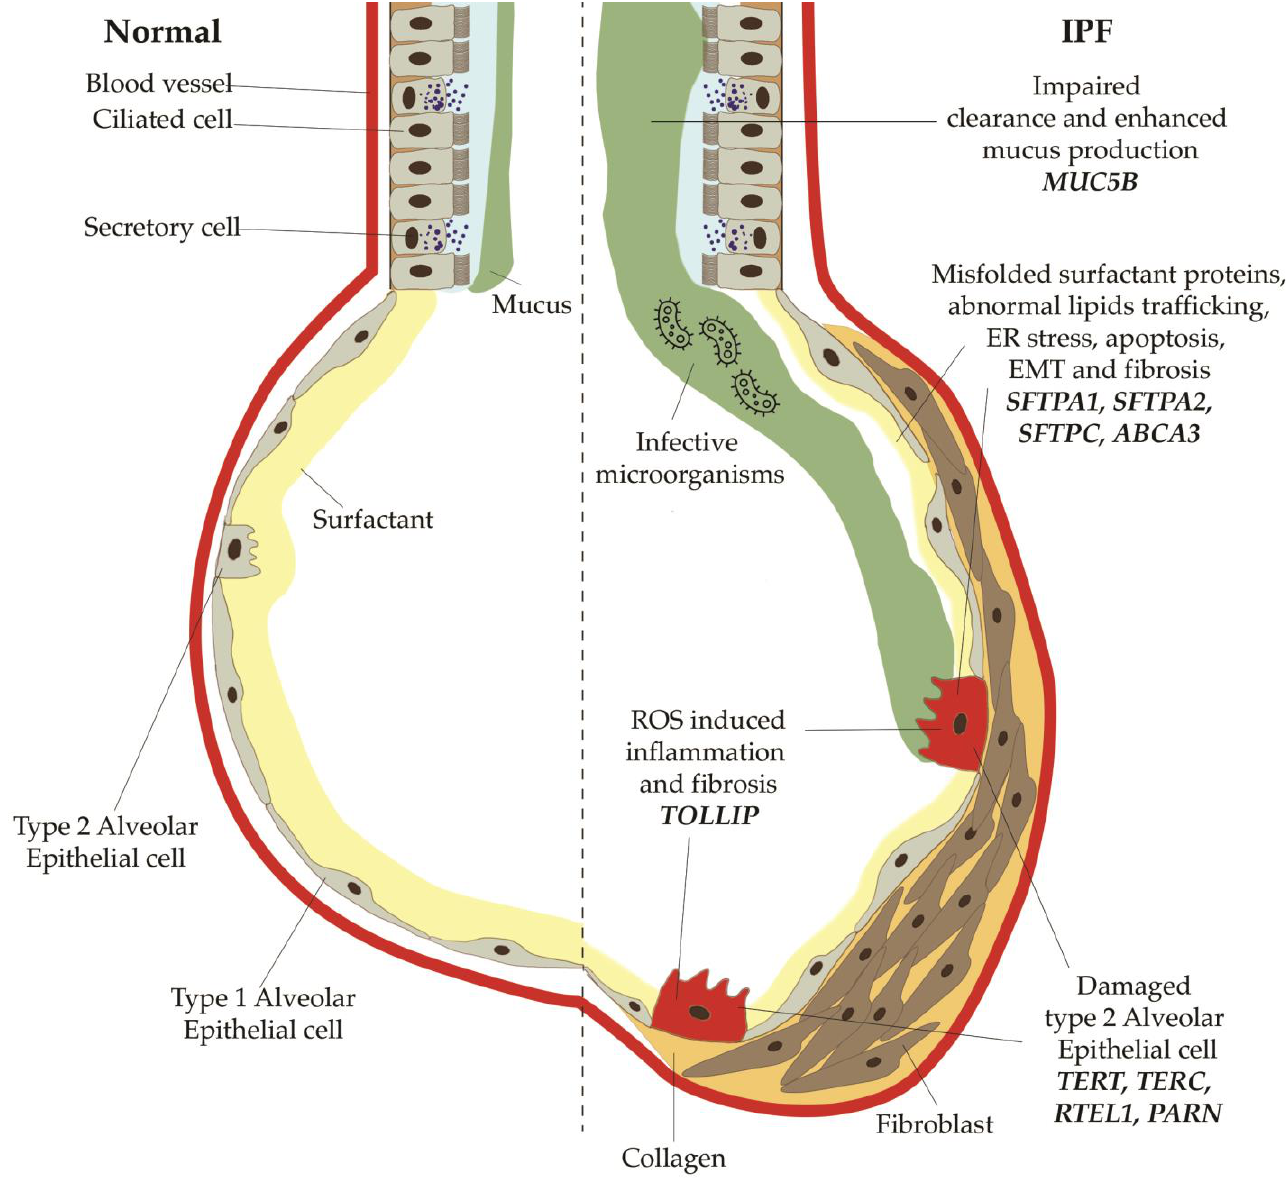
Figure 2. Main profibrotic mechanisms secondary to mutations or polymorphisms in the genes for telomerases, surfactant proteins, mucin 5B. Mutations in TERT , TERC , PARN and RTEL1 decrease the activity of telomerase, thus resulting in augmented shortening of telomeres. SFTPC , SFTPA1 , SFTPA2 , ABCA3 normally modulate and stabilize the alveolar surfactant tension; when altered, they transitions and apoptosis of type 2 alveolar cells. Polymorphisms of MUC5B , a regulatory mucin,